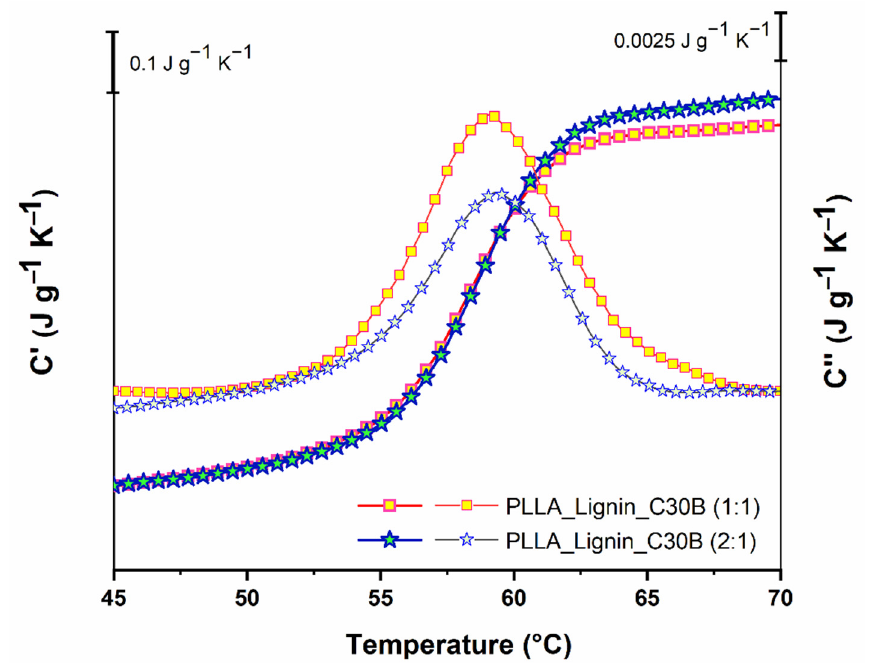
Figure 6. In-phase C ′ and out-of-phase C ″ components of C*, the complex heat capacity for PLLA_Lignin_C30B (1:1) and PLLA_Lignin_C30B (2:1) as a function of temperature from the MT-DSC heat-cool protocol: C ′ appears as a step and C ″ as a peak. The thick markers and lines are used to plot C ′ , whereas thin markers and lines refer to C ″ .